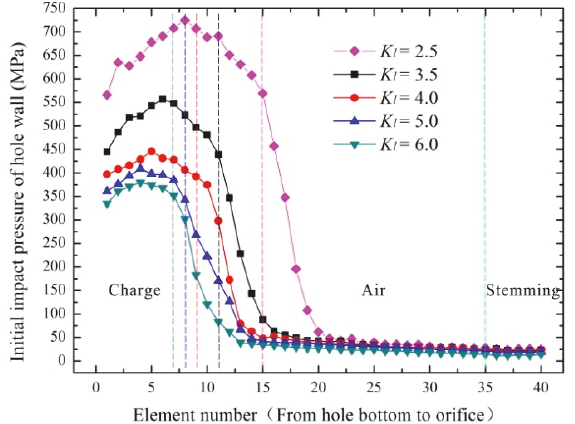
Figure 13: Initial shock pressure of borehole wall with middle air- decked charging